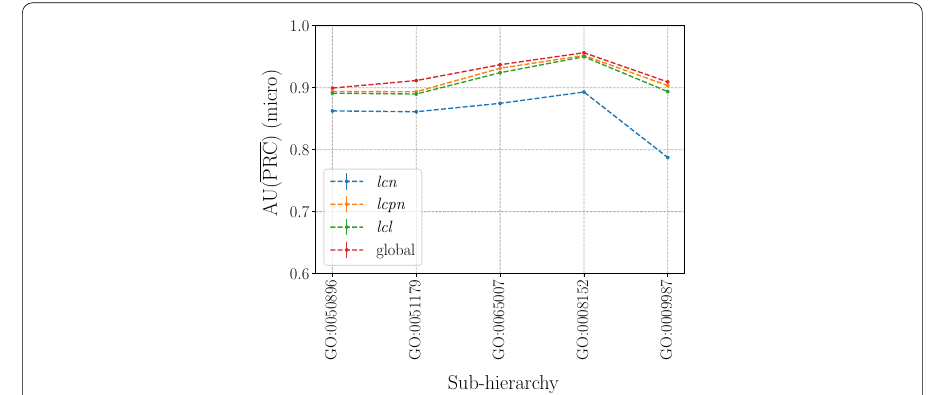
Fig. 6 Prediction performance of the proposed approach measured with the area under the average PR curve, i.e., AU( PRC ). The performance is measured independently per sub-hierarchy